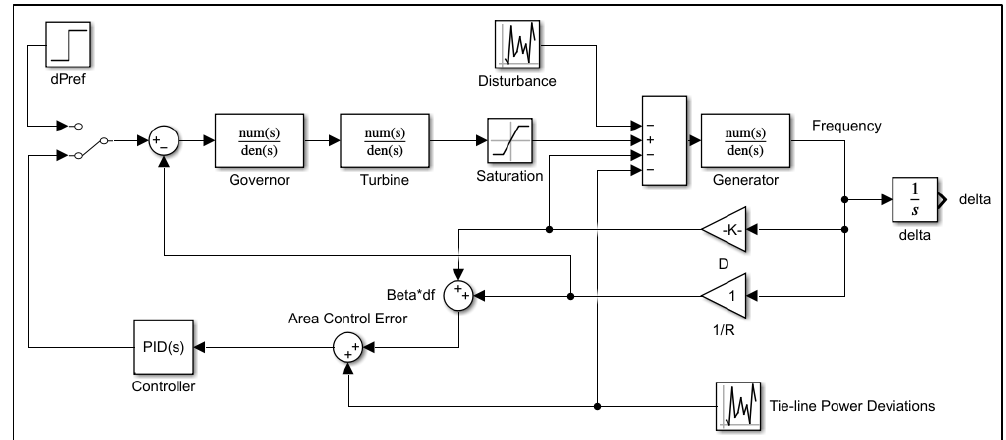
Figure 6. Simulink Model of a Typical Control Area.